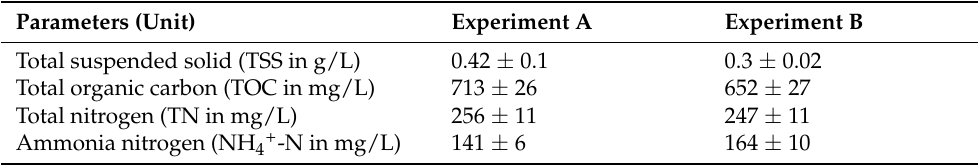
Table 1. Physicochemical composition of 5% v/v diluted PWW used as feed for the sets of experiments A and B. Values correspond to the mean ± standard deviation obtained of the feed samples analyzed every two days during the whole